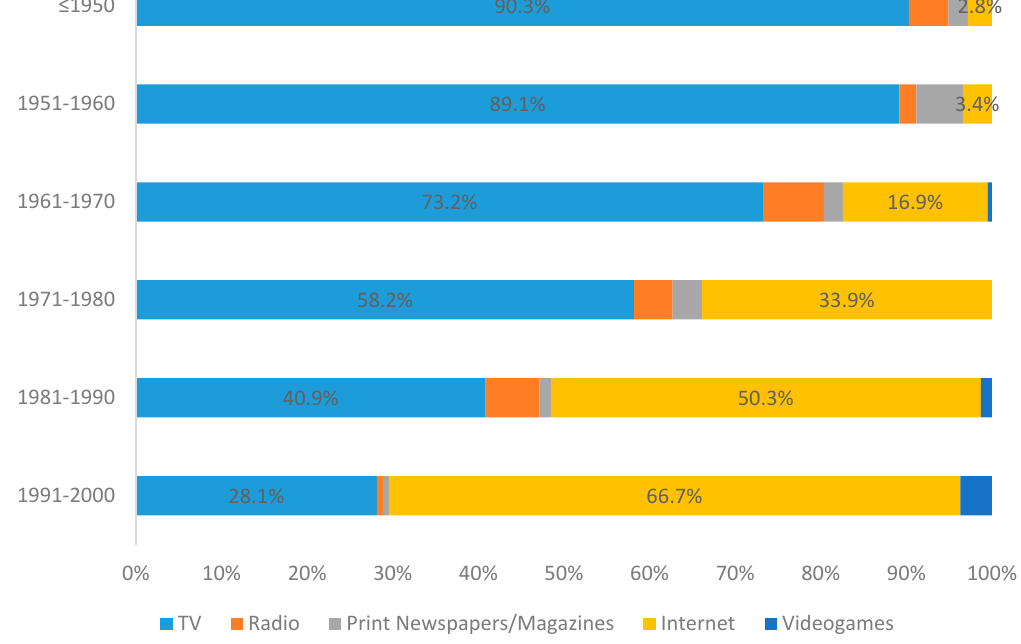
Figure 6. Most difficult activity to give up, by age cohort. Source: ERC2015—The new dynamics of audio-visual consumption in Portugal; n = 1018.